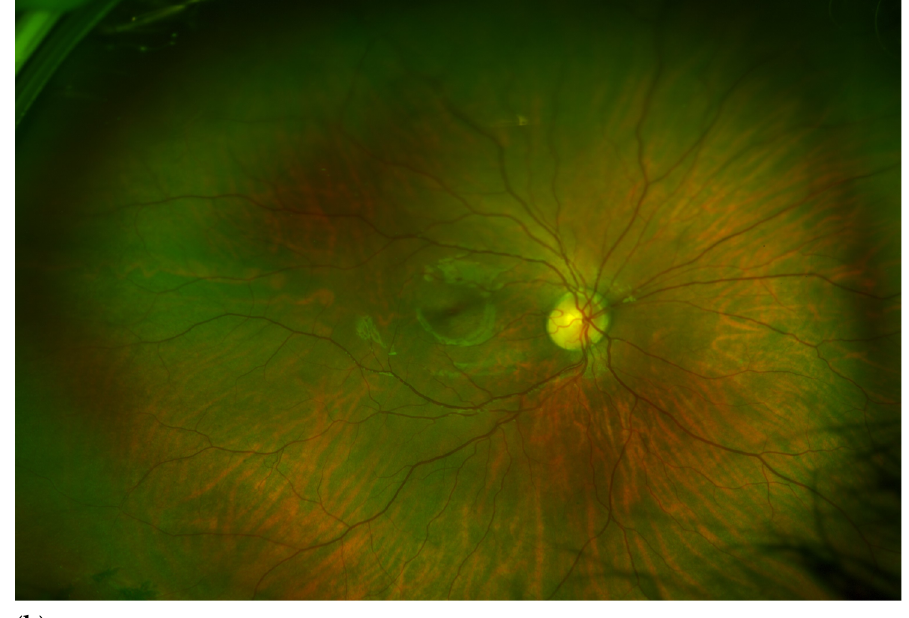
Figure 1. ( a ) Biomicroscopy photograph of proband’s microphthalmic eye. ( b ) Retinography showing no fundoscopic alterations in proband.